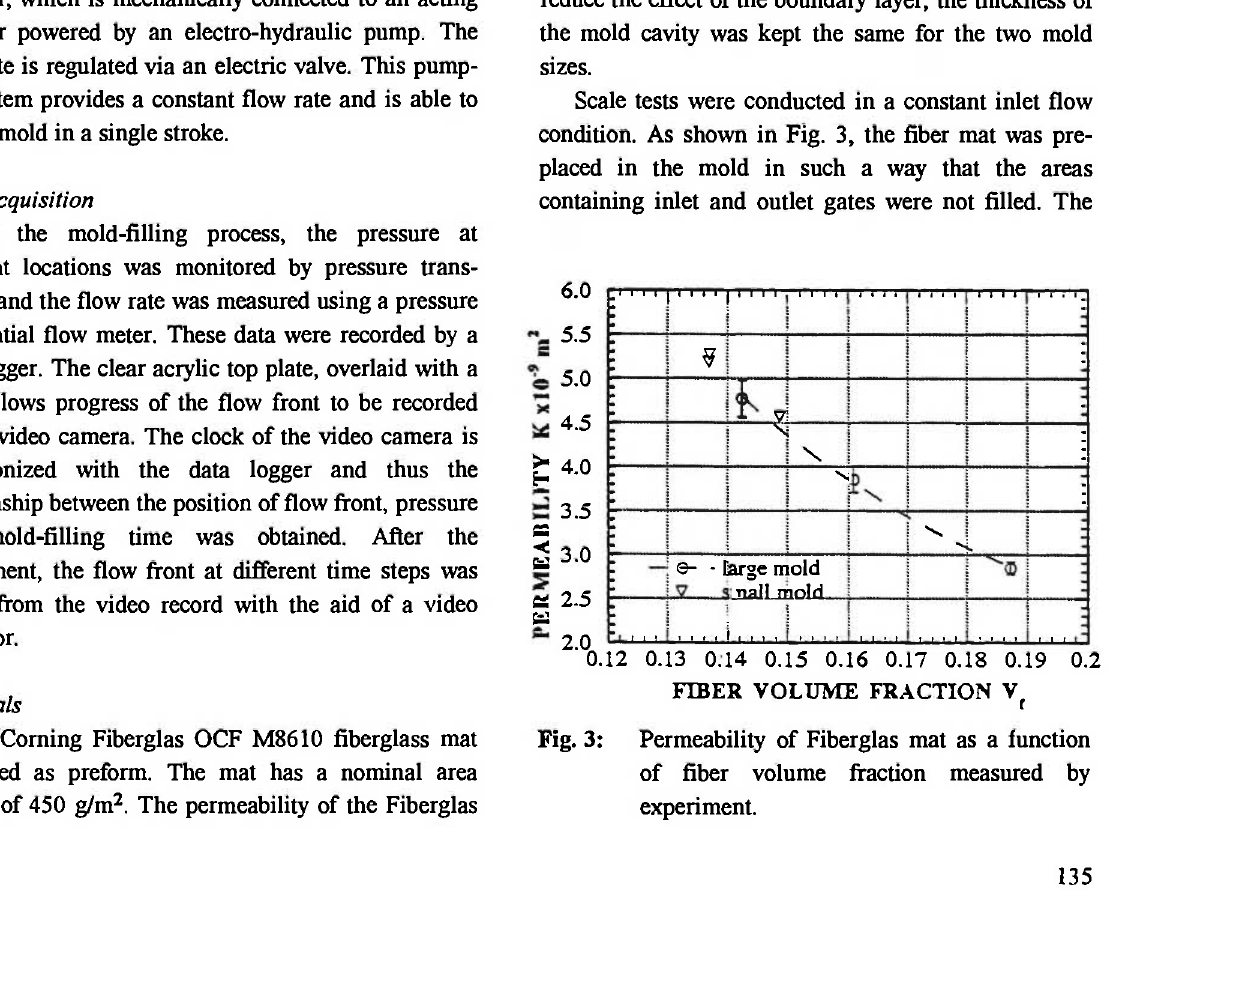
Fig. 2: Experimental set-up for mold-filling simulation for the RTM process.